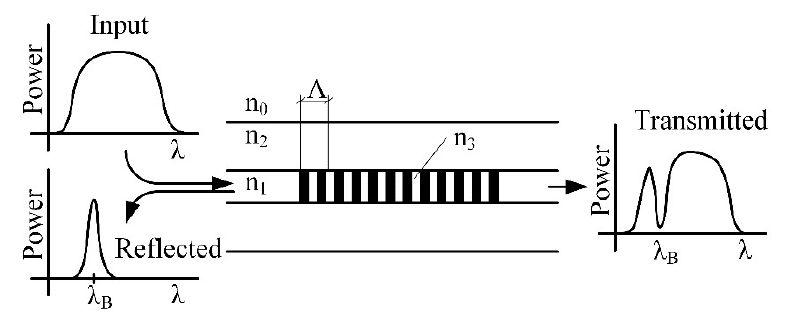
Figure 1. Structure of uniform Bragg